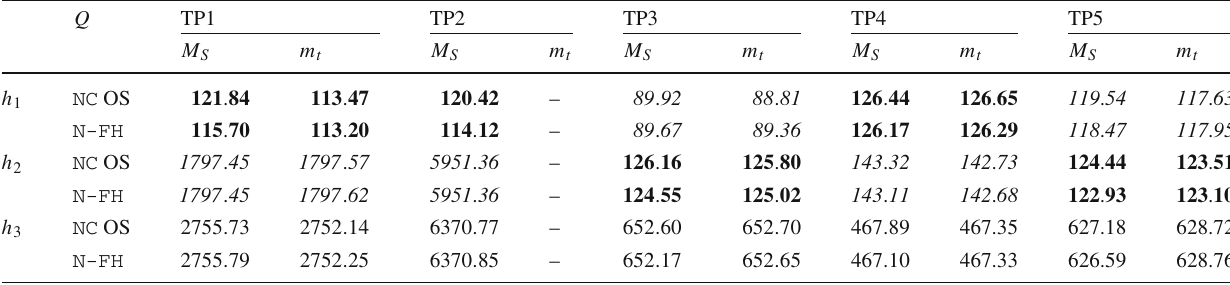
Table 4 Mass predictions for the CP -even scalars for TP1–TP5 when using the indicated versions of NMSSMCALC and NMSSM-FeynHiggs as specified in Sect. 5.1. The mass values of the SM-like scalar are written in bold fonts, those of the singlet-like scalar in